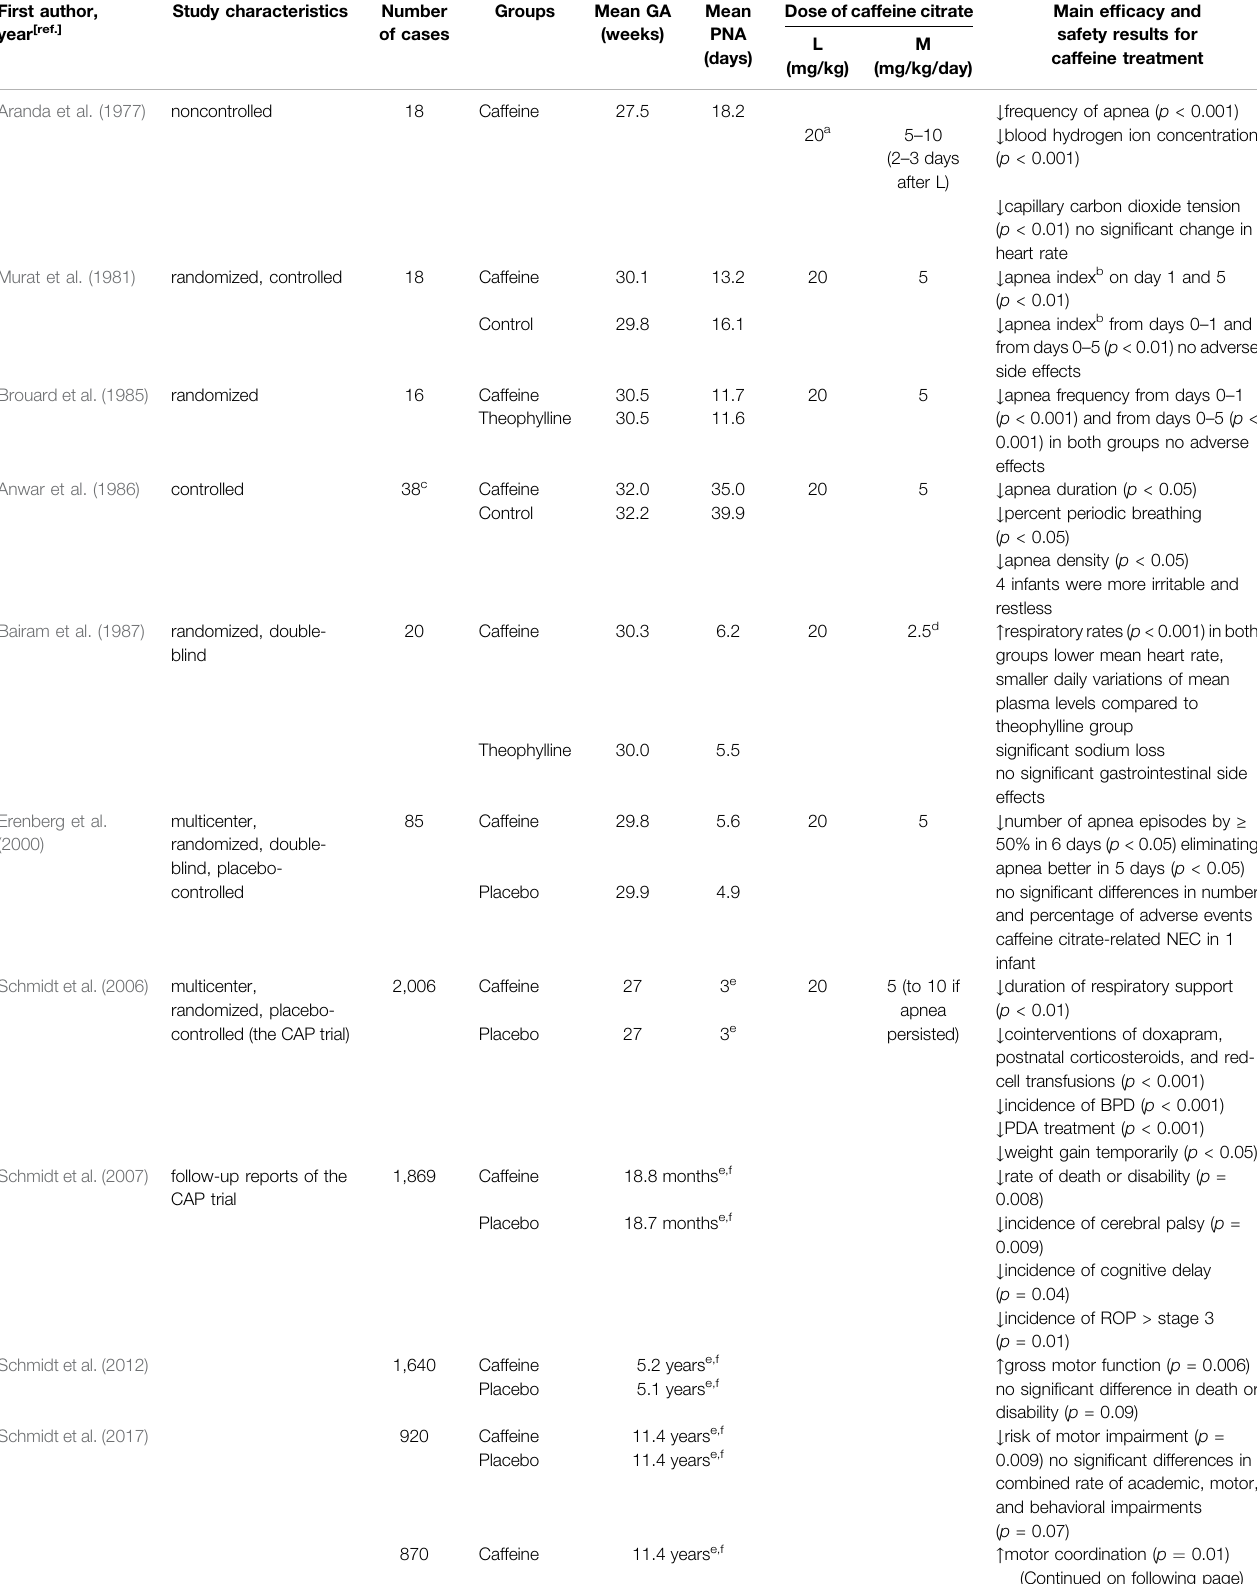
TABLE 3 | Main ef fi cacy and safety results in standard dose caffeine treatment